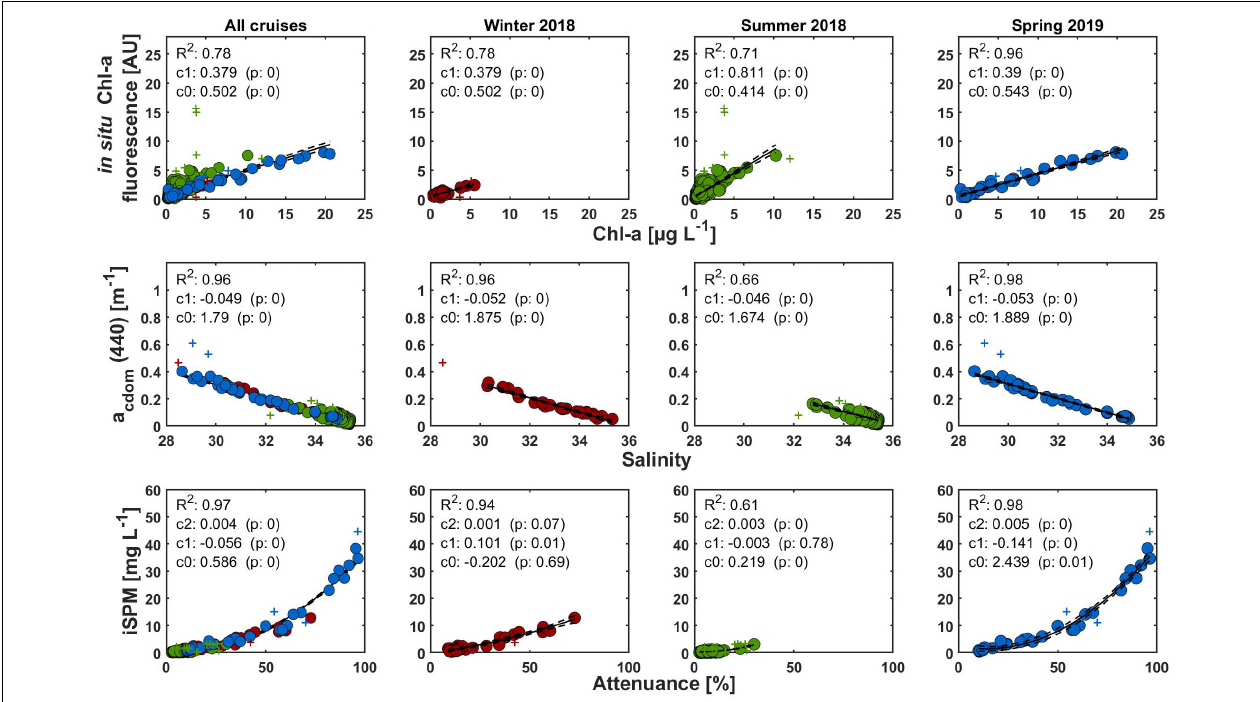
FIGURE 4 | Correlations between optically active substances and their respective in situ proxies. Data points considered as outliers (see text) are displayed as crosses and are not included in the fit represented by the solid line. The dashed lines give its 95% confidence interval. AU means that chl-a fluorescence is given in arbitrary